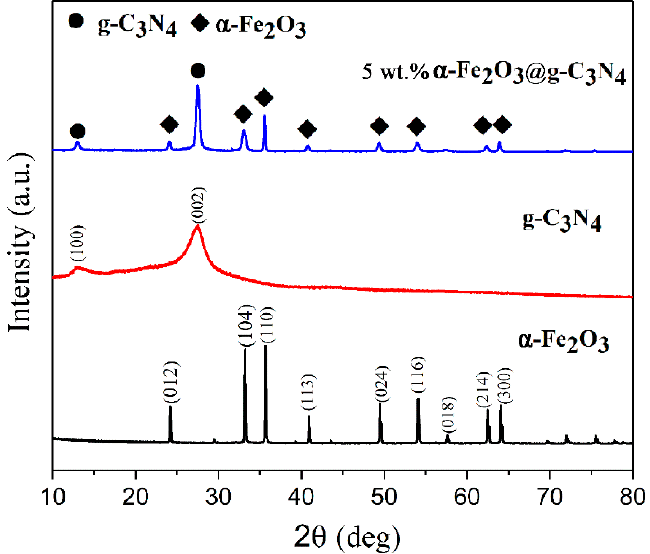
Figure 1. XRD patterns of different samples.